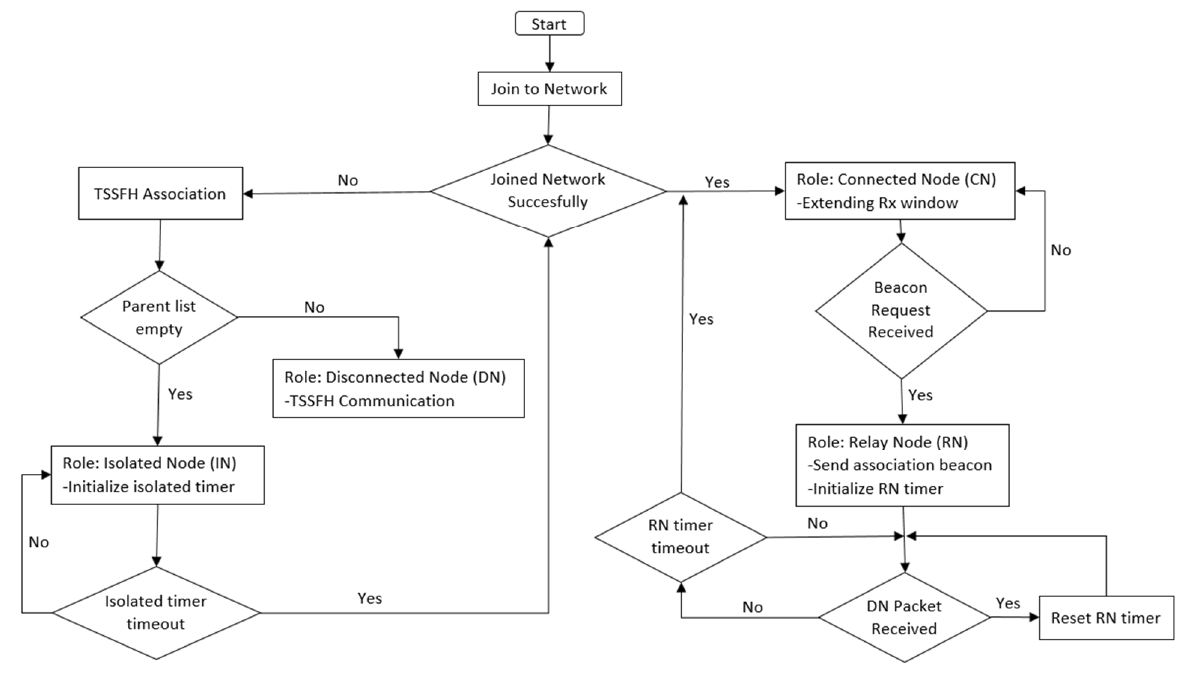
Figure 2. Flowchart showing the role changes of nodes.